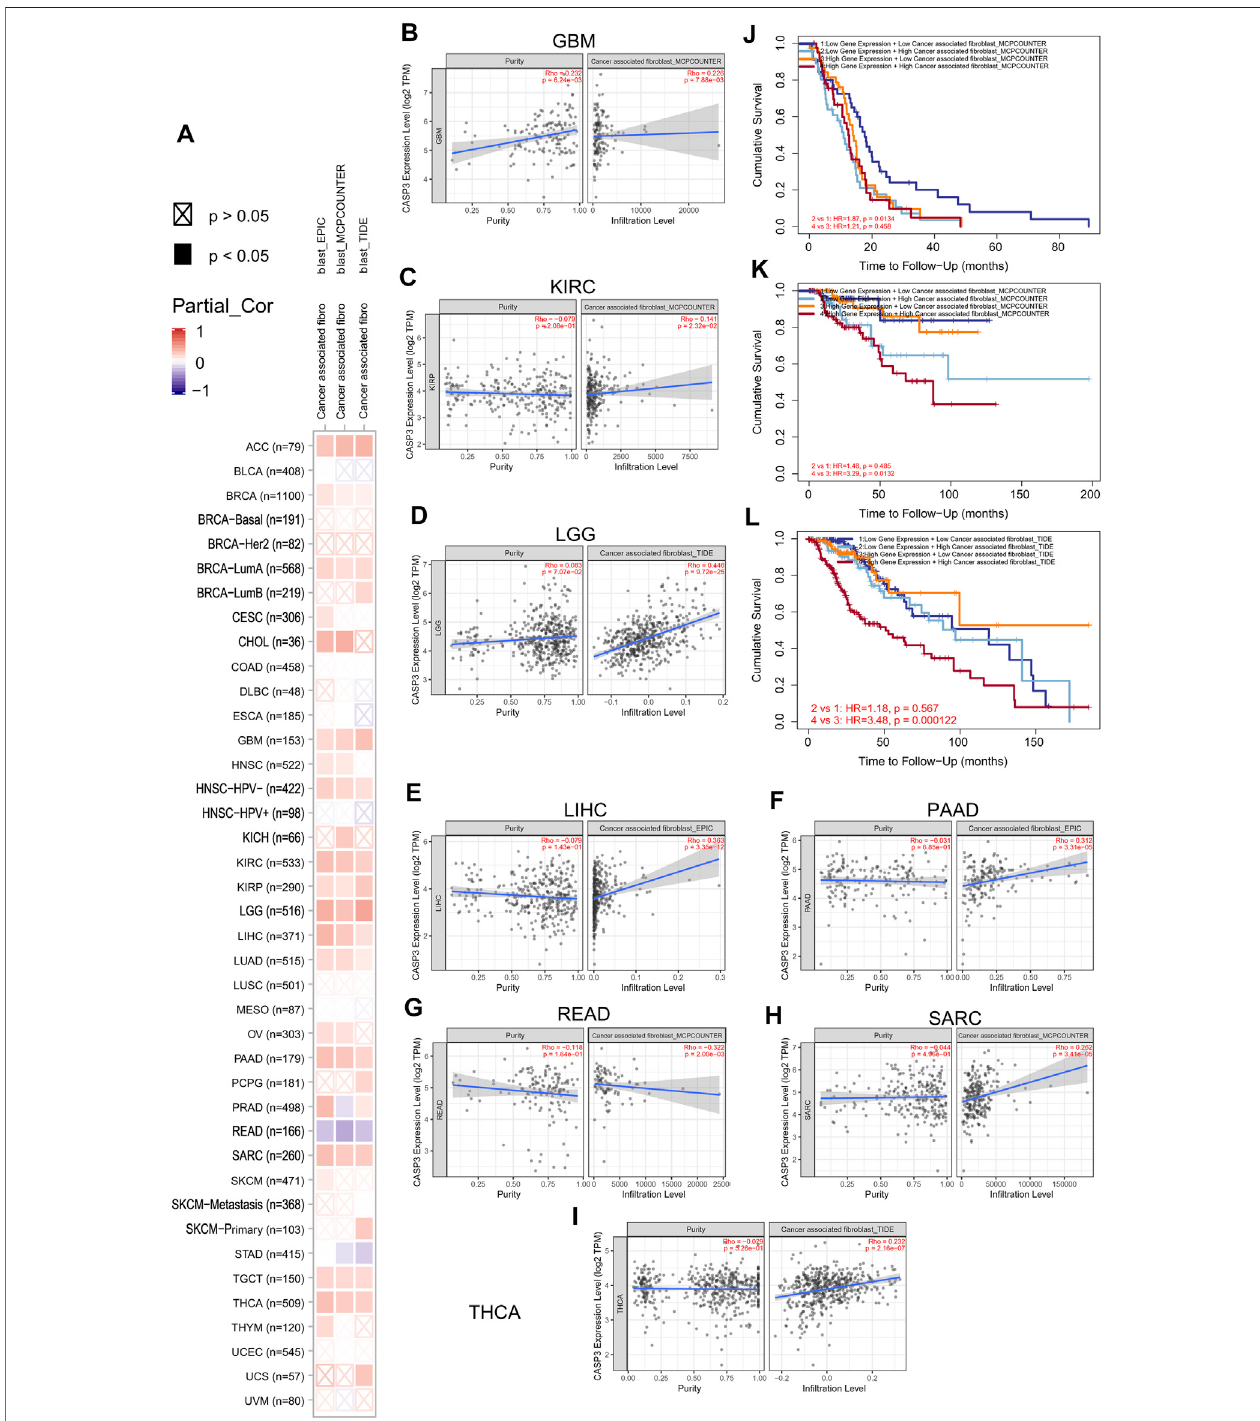
FIGURE 8 | Relationship between the expression of CASP3 and cancer-associated fi broblasts in fi ltration. (A) Relationship between expression of CASP3 and in fi ltration of 33 kinds of cancer-associated fi broblasts based on three algorithms. (B – I) expression of CASP3 in GBM, KIRC, LGG, LIHC, PAAD, READ, SARC, THCA and its correlation with fi broblasts in fi ltration. (J – L) Kaplan-Meier survival analysis of CASP3 gene expression and fi broblasts in fi ltration in relation to OS of GBM, KIRC and LGG.